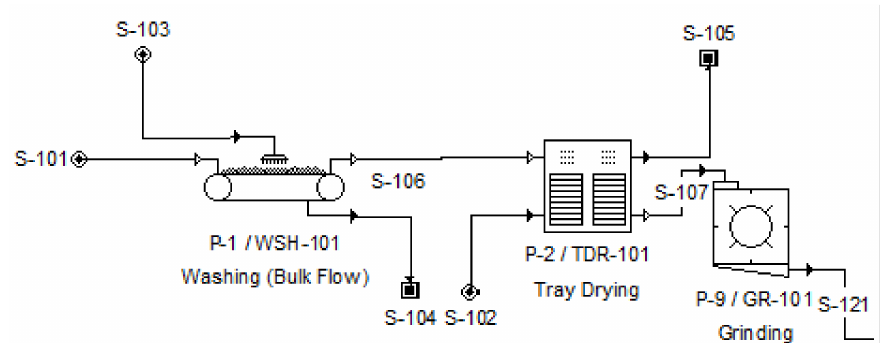
Figure 1. Pre-treatment processes for fresh longevity